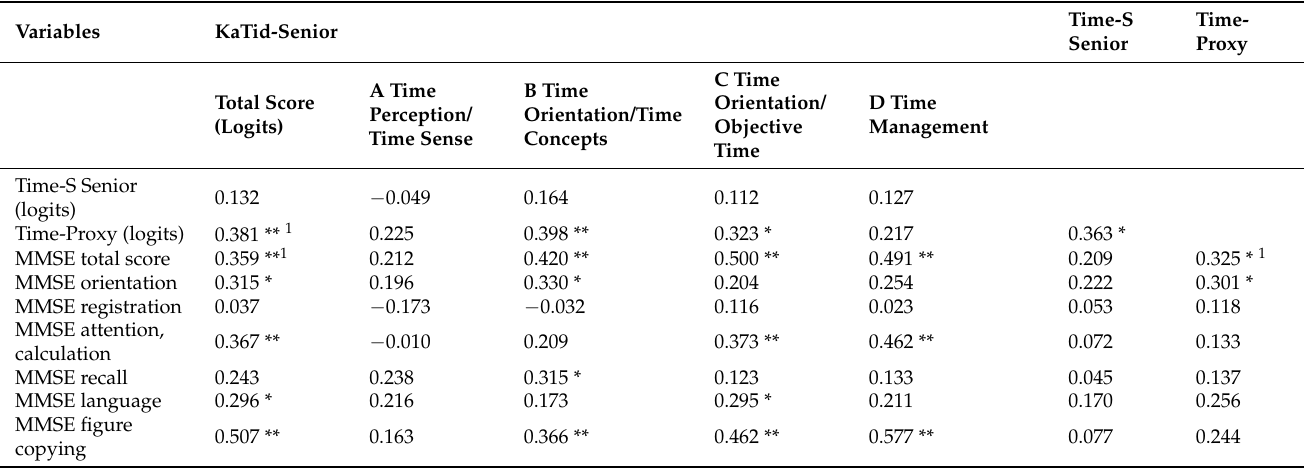
Table 2. Bivariate associations between time processing ability (KaTid-Senior), daily time